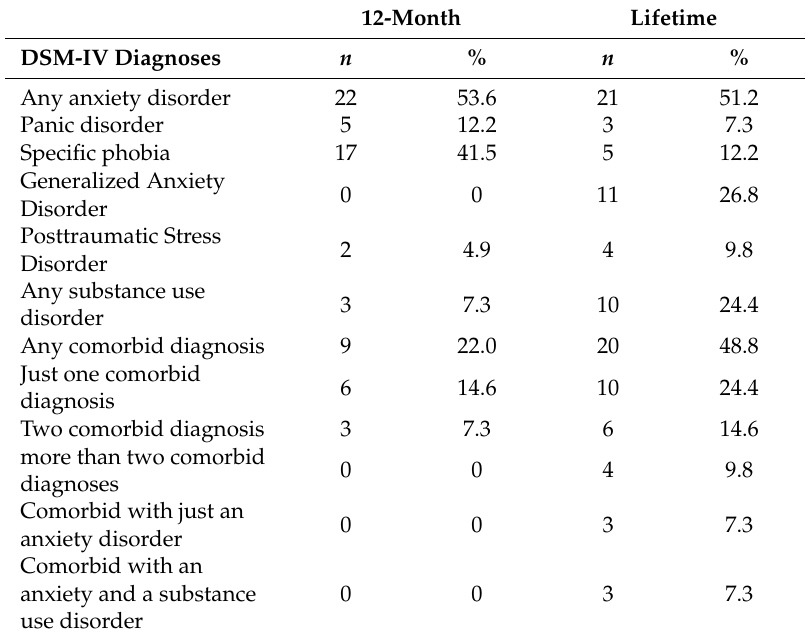
Table 1. Frequency of comorbid DSM-IV 12-month and lifetime diagnoses in the depressed participants ( n =